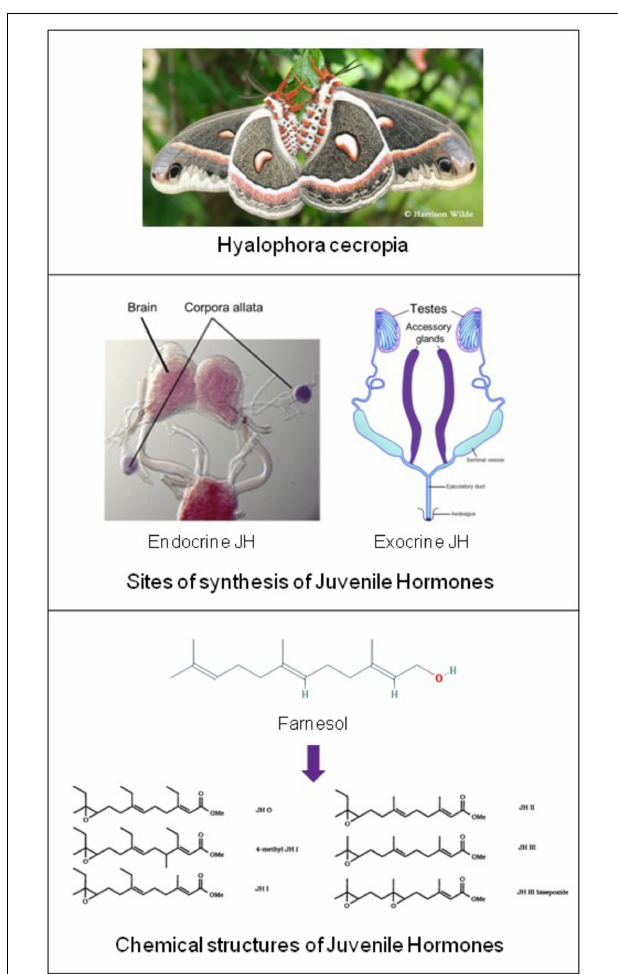
FIGURE 2 | Top: Hyalophora cecropia : in extracts from abdomens of adult males of this lepidopteran species Juvenile Hormone-I was chemically identified for the first time. Two sites of JH synthesis are known: the major site are the Corpora Allata (CA) which are present in all insects. CA do not accumulate JHs. CA-JH is endocrine JH. Cecropia Male Accessory (colleterial) Glands (MAGs) also synthesize JHs (Paroulek and Sláma, 2014), and they accumulate high amounts of JHs, in particular JH-I. Hitherto, JH synthesis by MAGs (= exocrine JH) has only been demonstrated in a few species ( Hyalophora cecropia and Aedes aegypti ). Top: Picture of H. cecropia : From Google images: Butterflies and Moths of North America. Collecting and sharing data about Lepidoptera (Photographer Harrison Wilde). Middle: Sites of synthesis of JH (in purple) Corpora allata of the silk moth Bombyx (From Google images: authors Daimon et al., 2012); Male accessory glands: image slightly modified after Google images: Cronodon.com – Insect Reproduction- (BotRejectsInc). Bottom: Linear chemical structures of farnesol [ Trans,trans -Farnesol or (E,E)-Farnesol] (From PubChem) and of Juvenile Hormones (JHs): Slightly modified after Bede and Tobe (2000). Their horseshoe 3D configuration is shown in Figure 7 . Thanks to all authors of the original figures. Copyright permission not